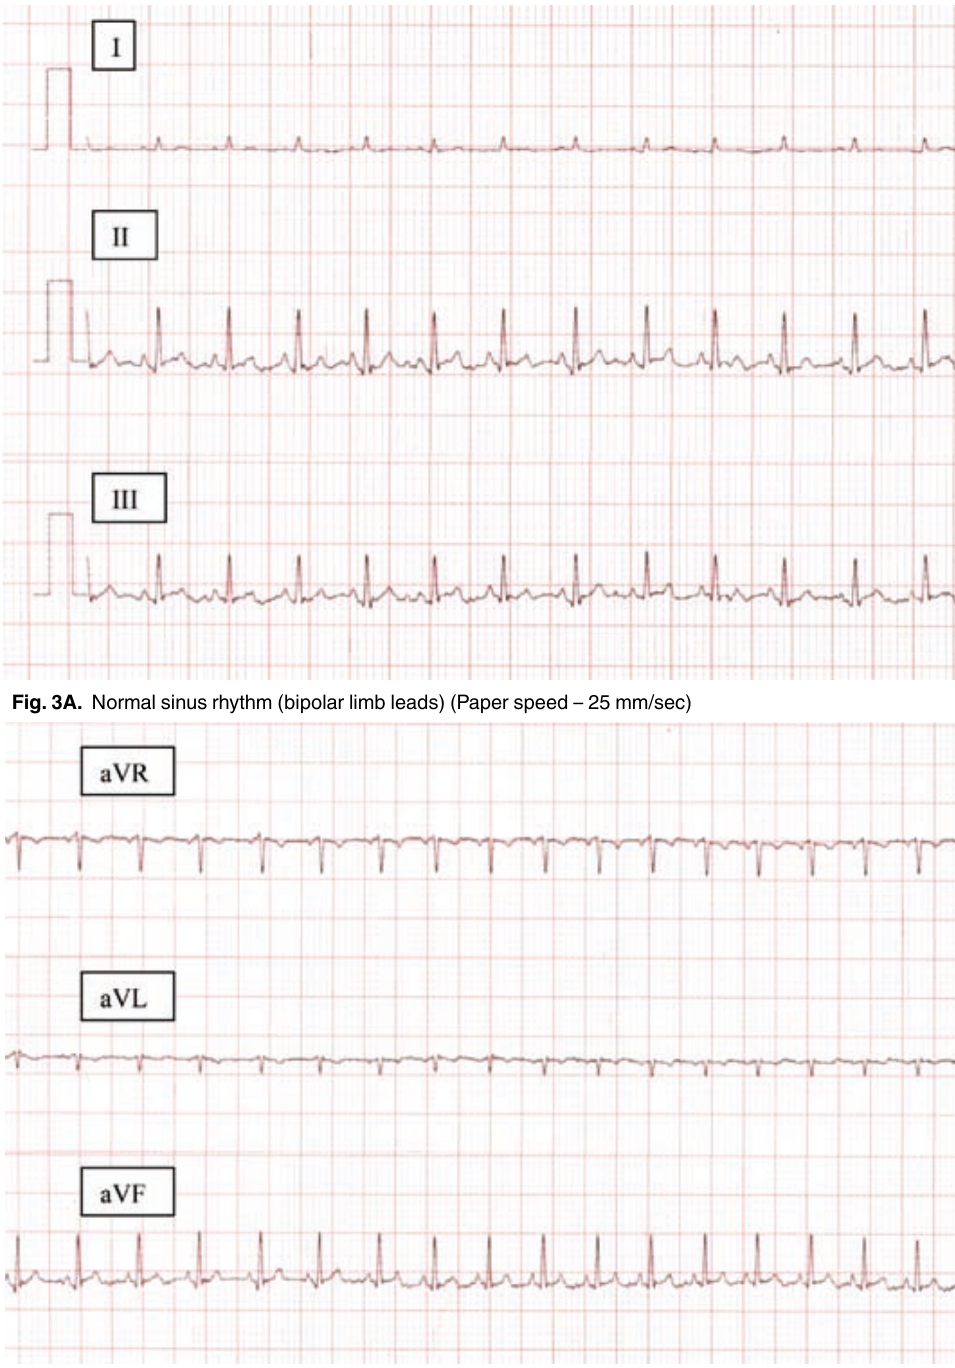
Fig. 3B. Normal sinus rhythm (augmented unipolar limb leads) (Paper speed – 25 mm/sec) QT interval of the study group as compared to complexes or due to hypocalcaemia, which the control group. Prolongation of QT interval occurred concurrently in a majority of these might be attributed to the widening of QRS cases. Hypocalcaemia caused